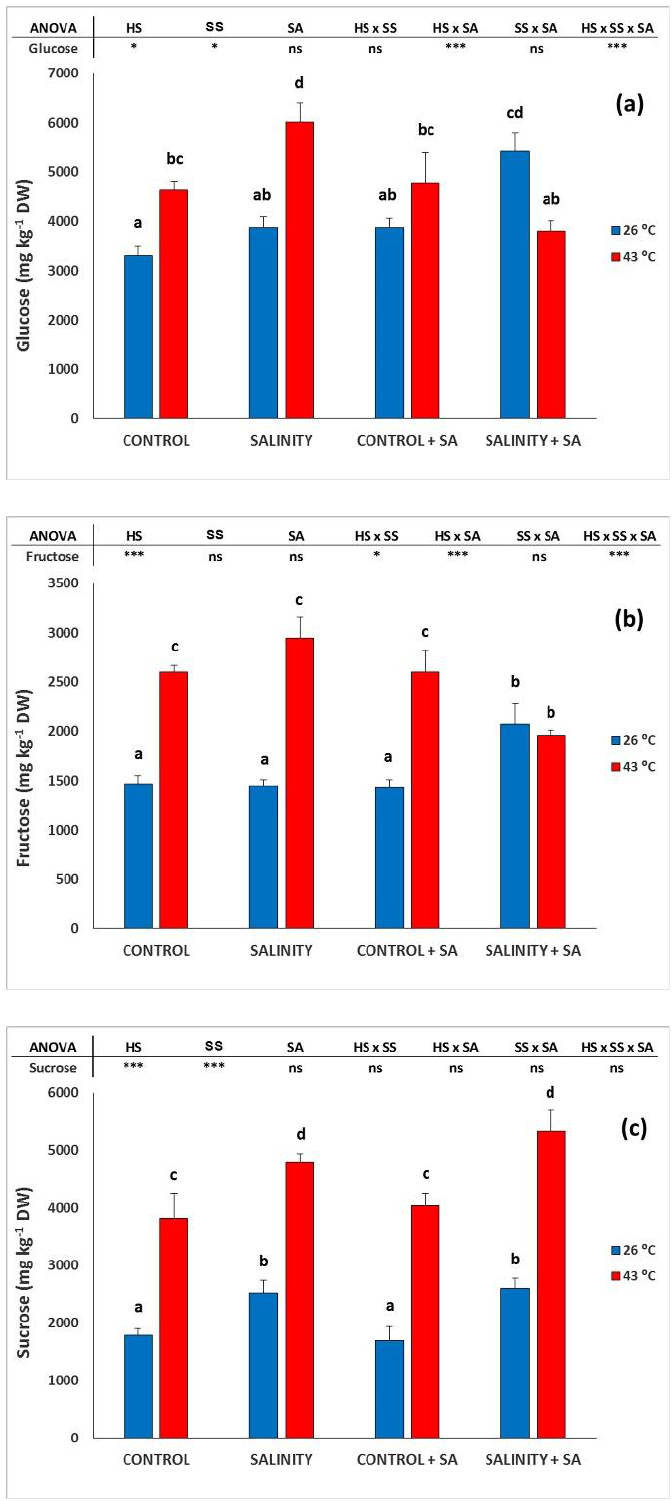
Figure 3. Effect of heat-shock and salinity, with or without salicylic acid, on the carbohydrates (glucose ( a ), fructose ( b ), and sucrose ( c )) in the leaves of pepper plants. The * refers to significant differences at the level of p ≤ 0.05; *** p ≤ 0.001; n.s. , not significant. Different lowercase letters denote significant differences between columns, p < 0.05 HS is heat stress; SS is salinity stress; SA is salicylic acid.